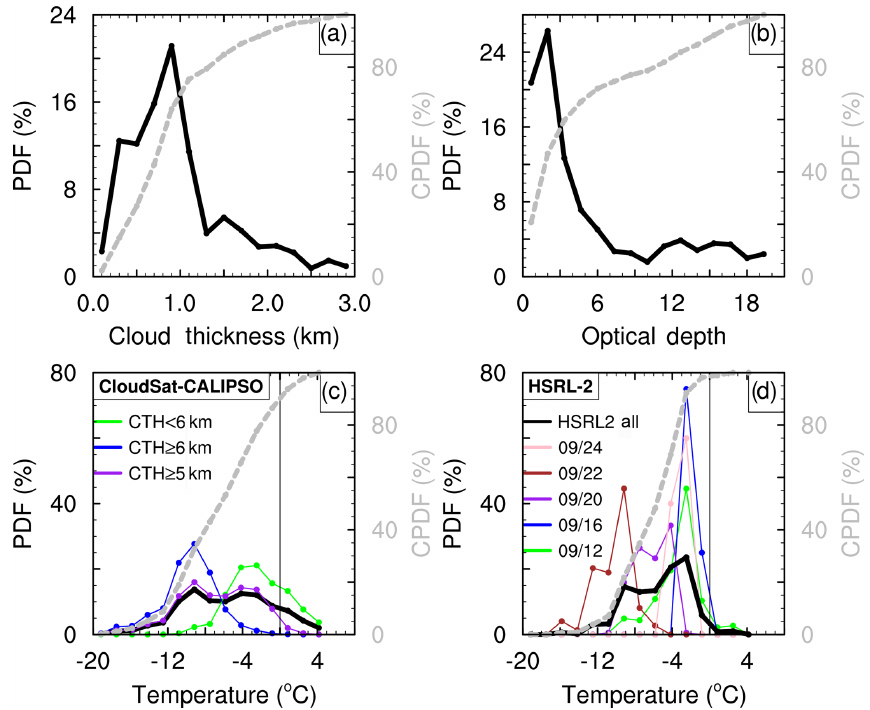
Figure 5. The probability (PDF; solid black lines) and cumulative (CPDF; dashed gray lines) distributions of mid-level cloud properties. These distributions are obtained for mid-level (a) cloud thickness (km), (b) cloud optical depth, and (c) cloud temperature ( ◦ C) from the CloudSat–CALIPSO merged dataset between 3 and 8km altitude in July and October (2006–2010) averaged over the southeast Atlantic (black boxes shown in Fig. 4). Panel (c) also shows the temperature distribution subset in different cases of mid-level cloud-top heights. (d) Cloud temperature distribution ( ◦ C) collocated with HSRL-2-derived mid-level clouds (see Fig. 2b) and obtained for the individual days (colored lines) and the campaign period (HSRL2 all; black line for PDF and gray line for CPDF) during ORACLES in September 2016. The thin vertical line in (c) and (d) shows the 0 ◦ C